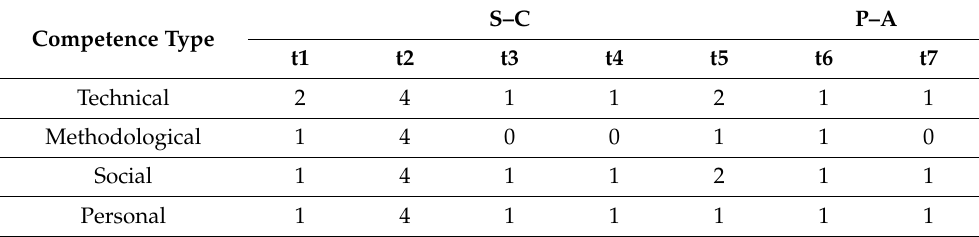
Table 13. Overall relevance of competence in adopting different ICT